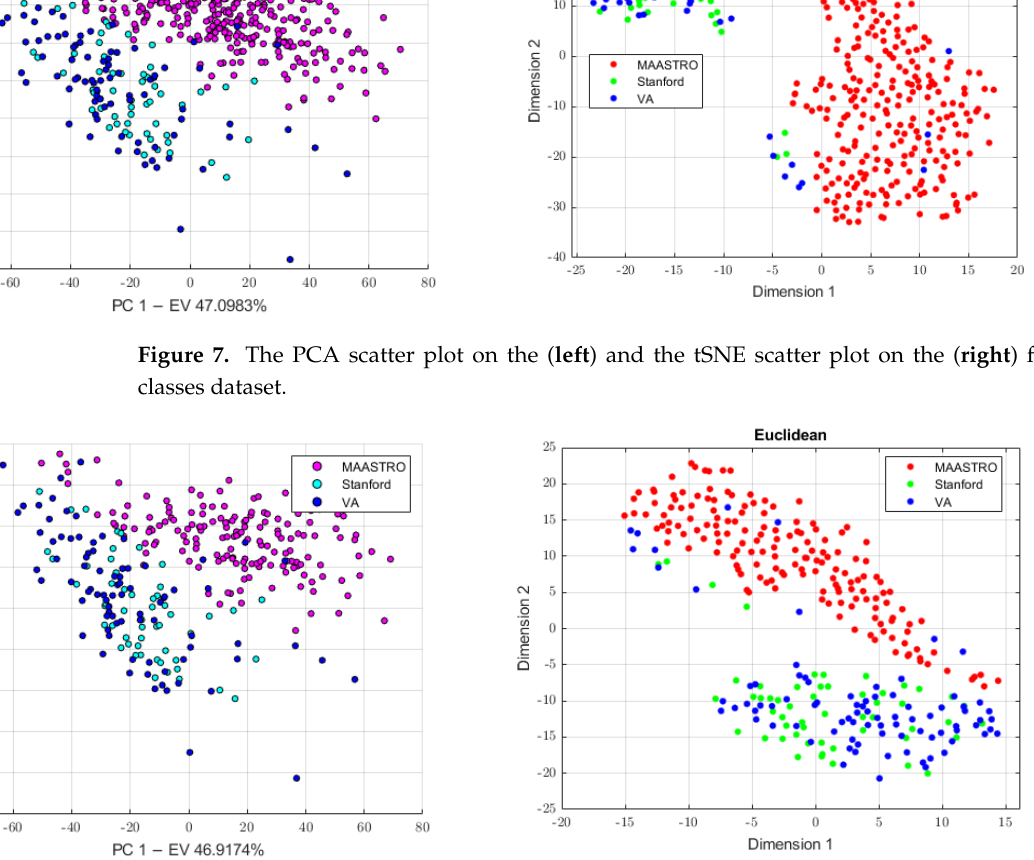
Figure 8. The PCA scatter plot on the ( left ) and the tSNE scatter plot on the ( right ) for the 2-classes dataset.